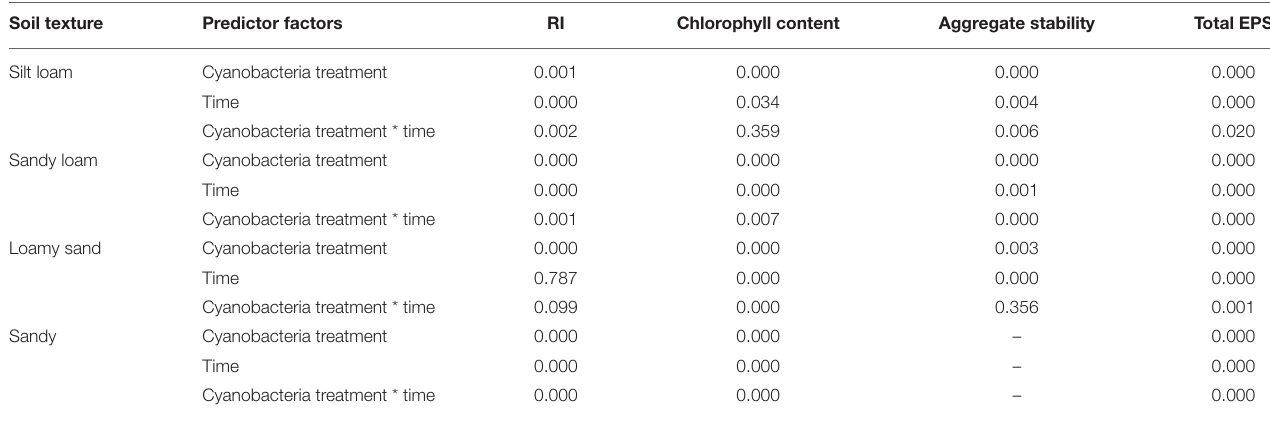
TABLE 2 | p -values resulting from the GLM analysis considering as categorical predictors the cyanobacteria treatment (control, P. ambiguum , S. javanicum ) and time of incubation (30, 60, and 90 days). Soil